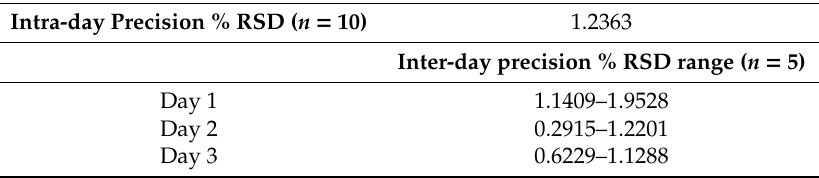
Table 5. Intra-and inter-day precision data for CLA